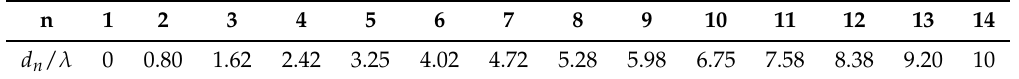
Table 2. Locations for the non-reweighted broadside design example, M = 301.